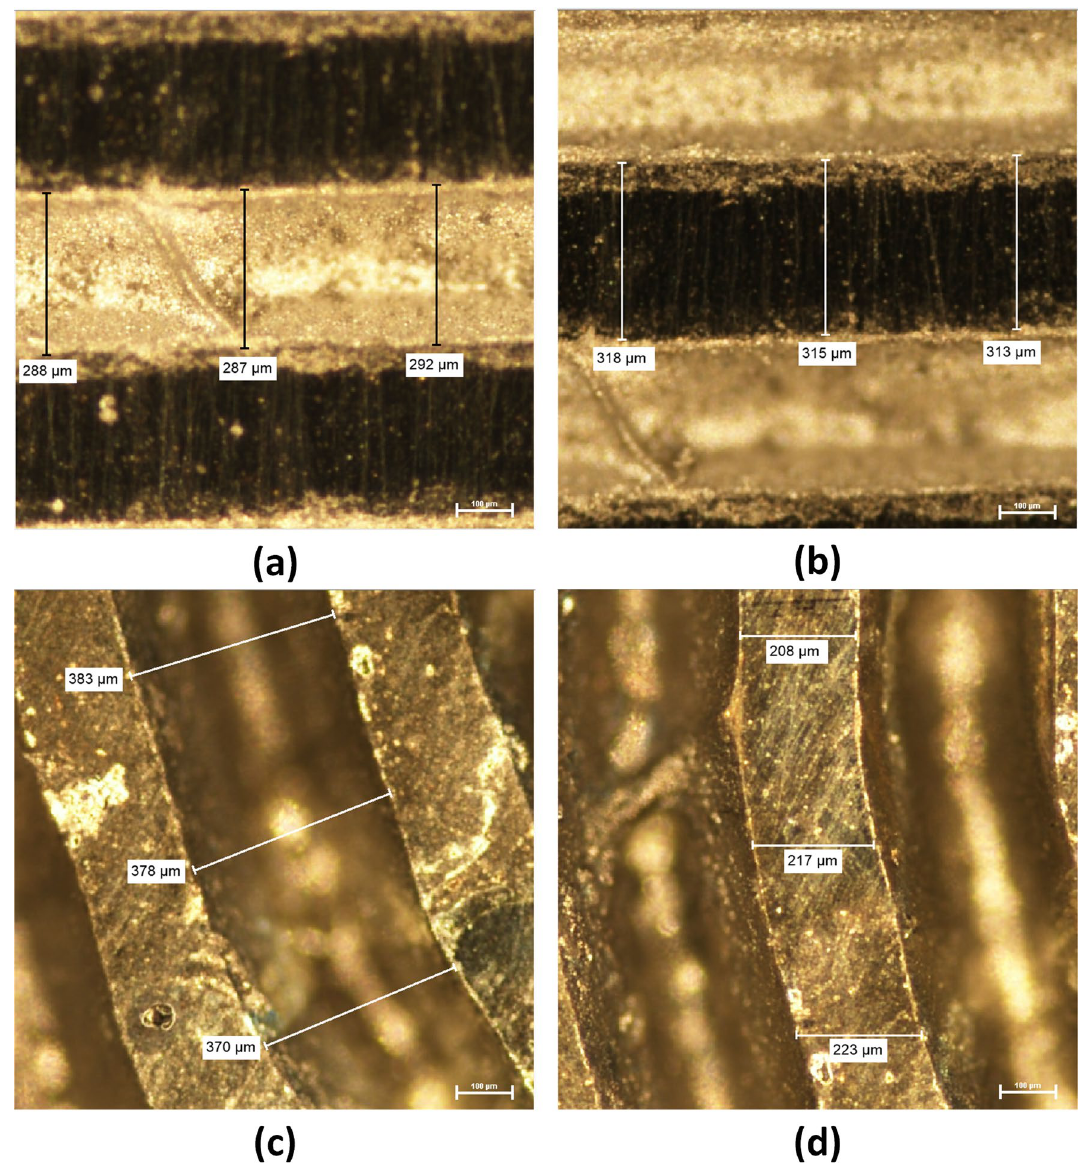
Figure 3. Optical images of laser ablated transduction features. ( a ) Straight profile, ( b ) straight profile electrode inter-spacing, ( c ) curved profile, and ( d ) curved profile electrode